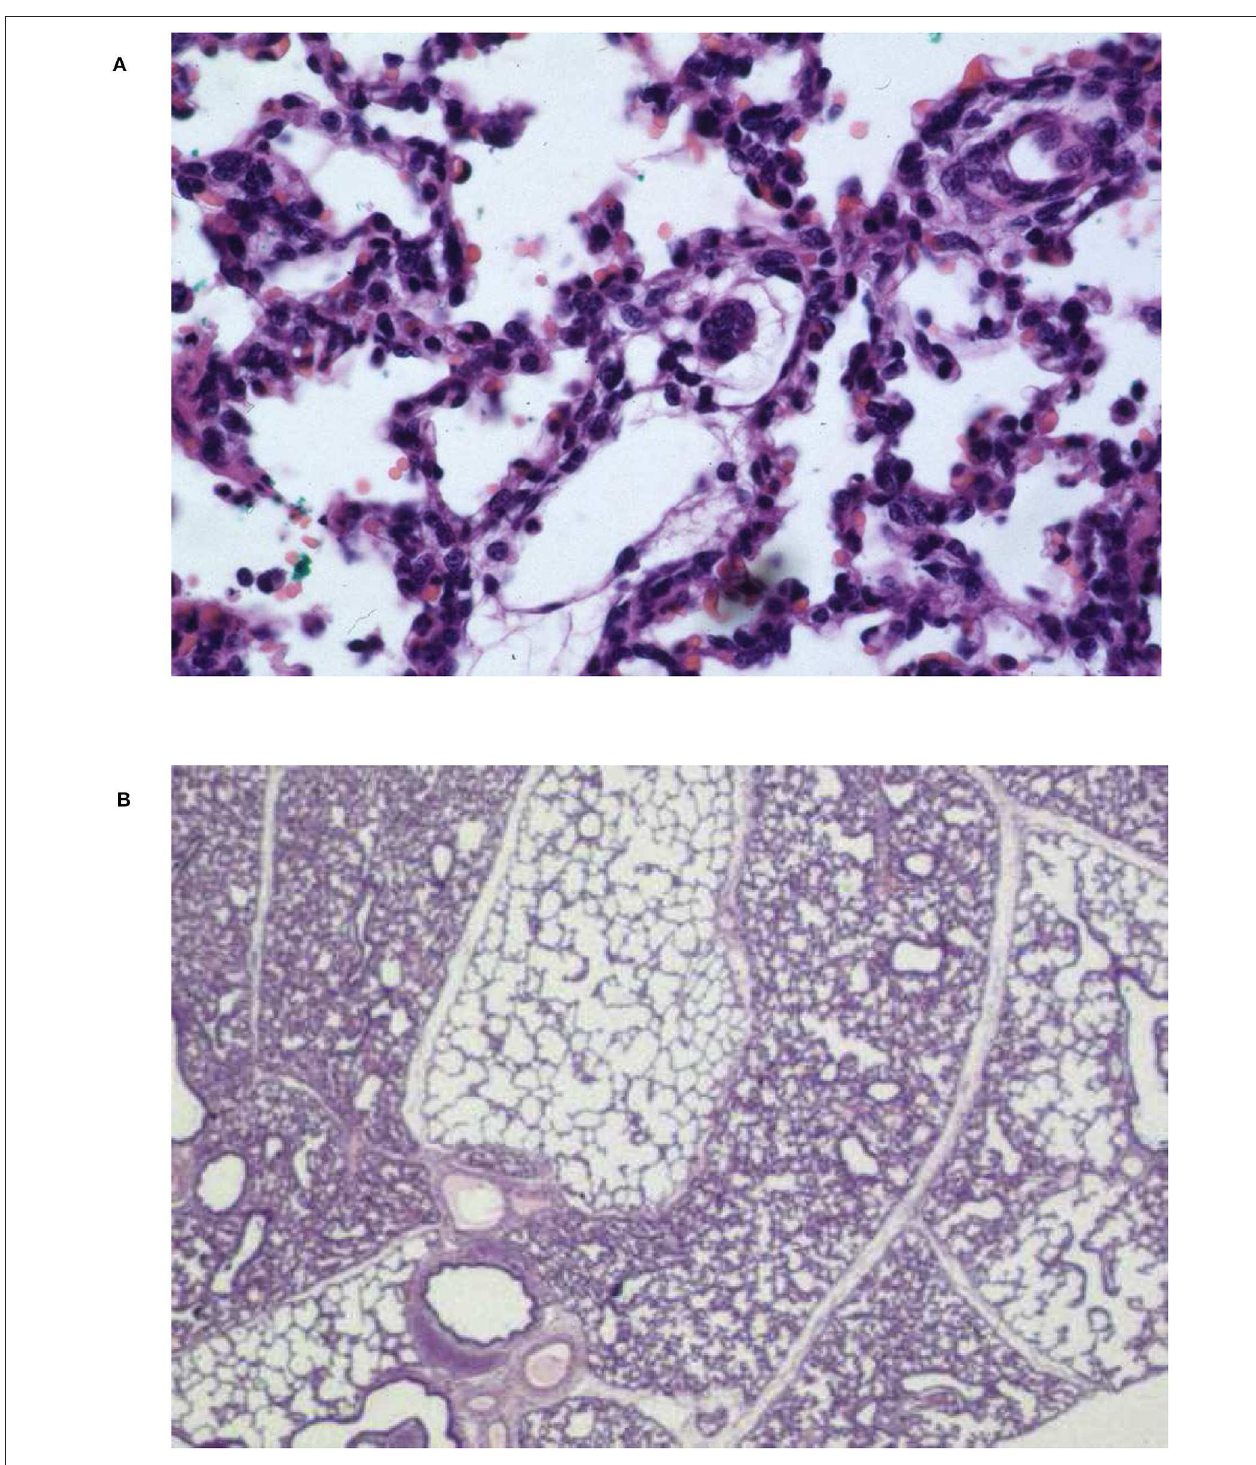
FIGURE 1 | Microscopic findings of a control piglet after 24h of mechanical ventilation following repeated airway lavage. (A) Diffuse alveolar collapse next to overdistention, severely thickened alveolar septae. Some hyaline membrane formation and alveolar basement denudation is evident. Abundant cellular infiltration with PMNL and macrophages in the pulmonary interstitium and in the alveolar spaces. Infiltrations with red blood cells as sign of diffuse pulmonary hemorrhage and coagulation activation. (B) Lobuli with alveolar collapse adjacent to overdistention containing proteinaceous alveolar edema. Hematoxylin and eosin staining, oil × 1,200 (A) , × 300 (B)